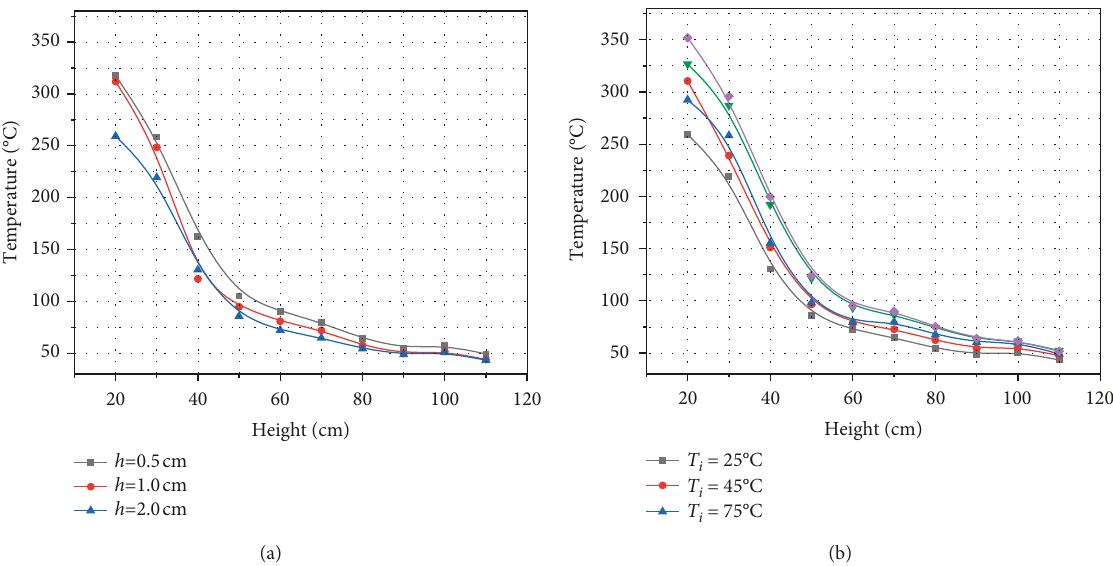
Figure 7: Fire plume temperature as a function of height for different experimental conditions, (a) different fuel thicknesses, and (b) different initial